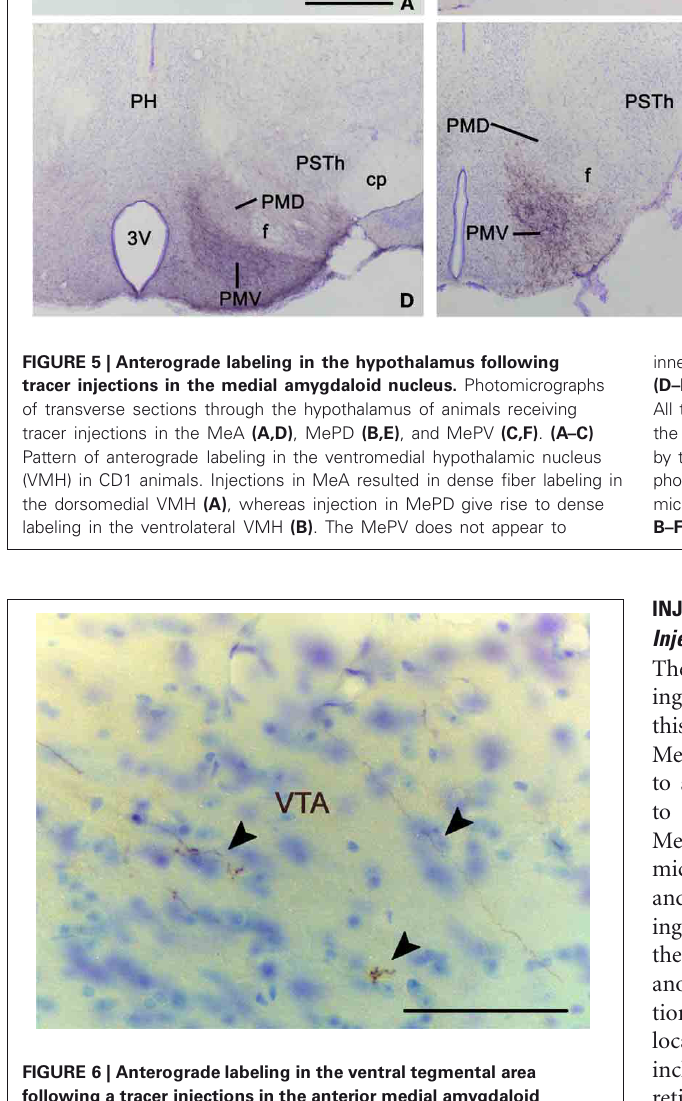
FIGURE 6 | Anterograde labeling in the ventral tegmental area following a tracer injections in the anterior medial amygdaloid nucleus. Arrowheads point to scattered labeled fibers. Experiment performed in a CD1 mice. Scale bar: 25 µ m.